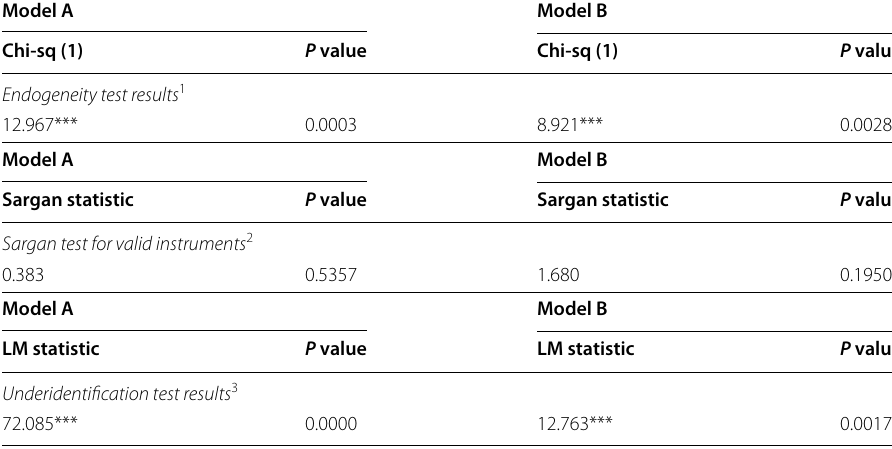
Table 13 Provincial analysis post estimation test